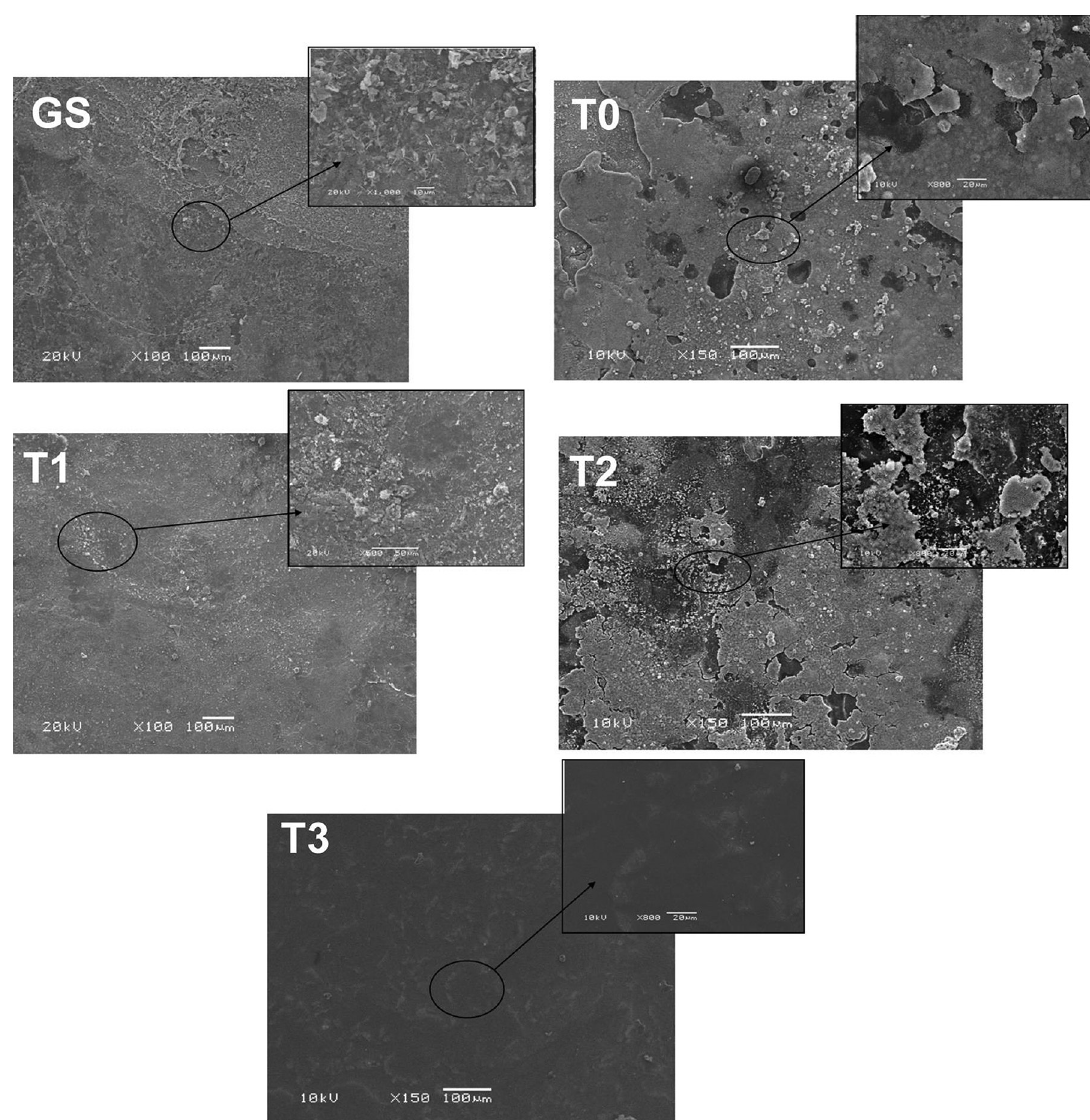
Figure 12. Images obtained after the electrochemical impedance